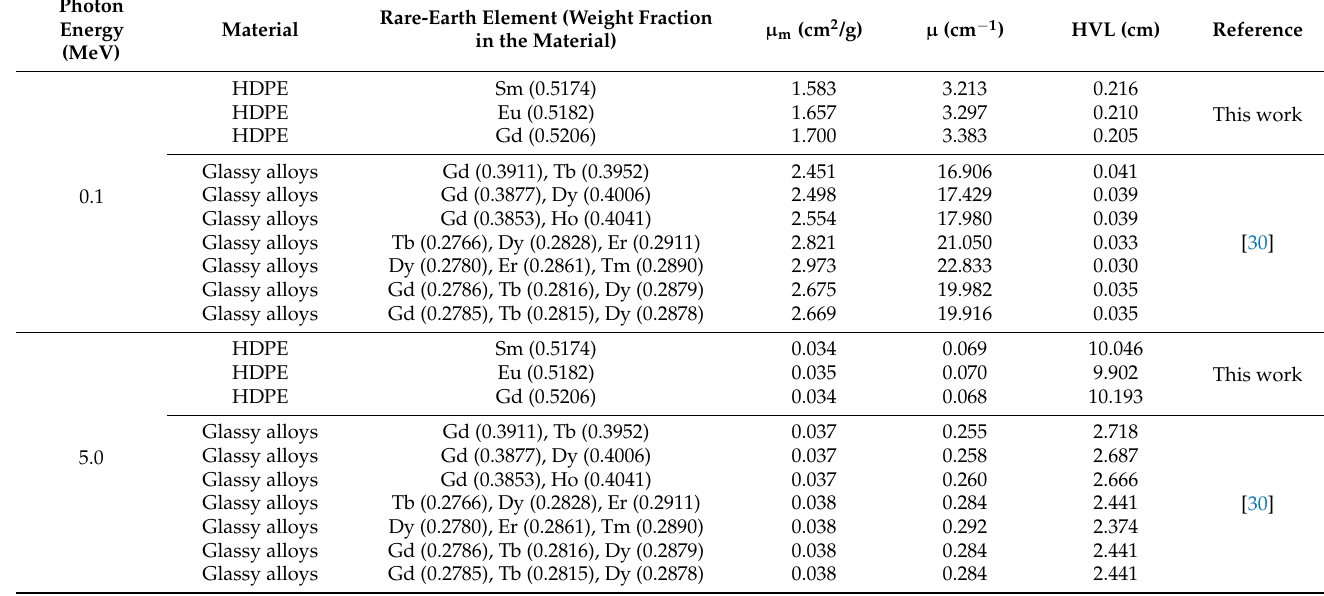
Table 8. Comparative µ m , µ , and HVL values of Sm 2 O 3 /HDPE, Eu 2 O 3 /HDPE, and Gd 2 O 3 /HDPE composites with glassy alloys containing different types and contents of rare-earth elements (Gd, Tb, Dy, Ho, Er, and Tm) at photon energies of 0.1 and 5